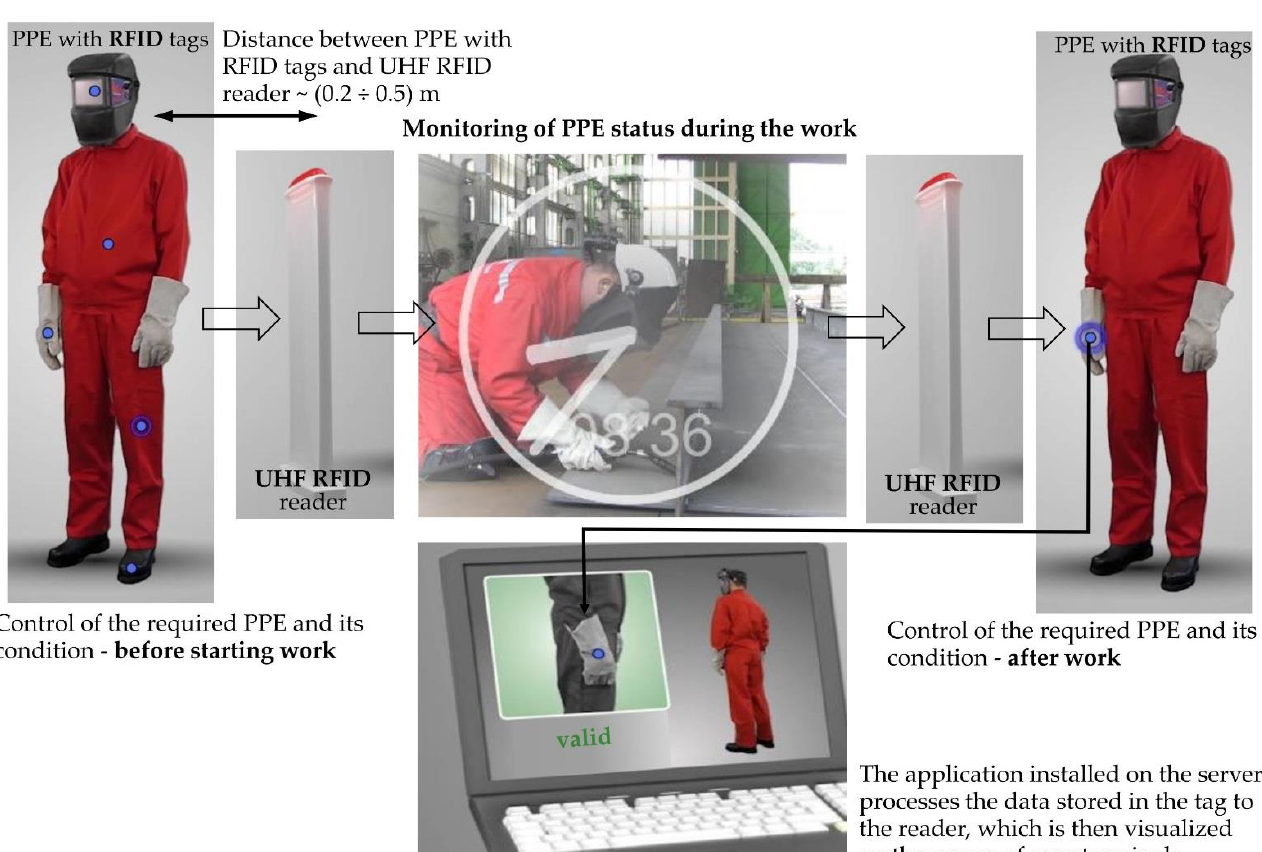
Figure 2. The principle of operating the system of automatic identification and management of PPE in the workplace.